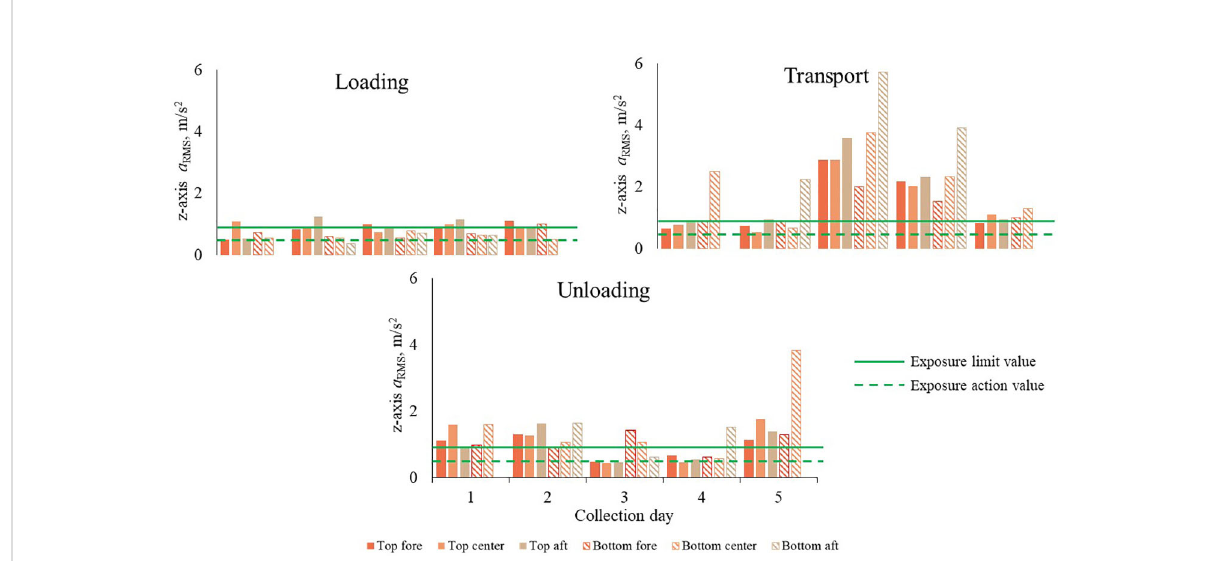
FIGURE 7 z-axis root mean square (RMS) experienced by pigs transported within two decks (DEC; T, Top; B, bottom) and three sections (SEC; F, fore; C, center; A, aft) of two trailers during loading (LOD), transport (TRA), and unloading (UDL). Least squares means encompass two daily market-weight pig loads recorded over 5 consecutive days. Exposure action value (EAV; 0.43 m/s 2 ; dotted green line) and exposure limit value (ELV; 0.86 m/s 2 ; solid green line) correspond to “ injury possible ” and “ injury likely ” comfort levels,